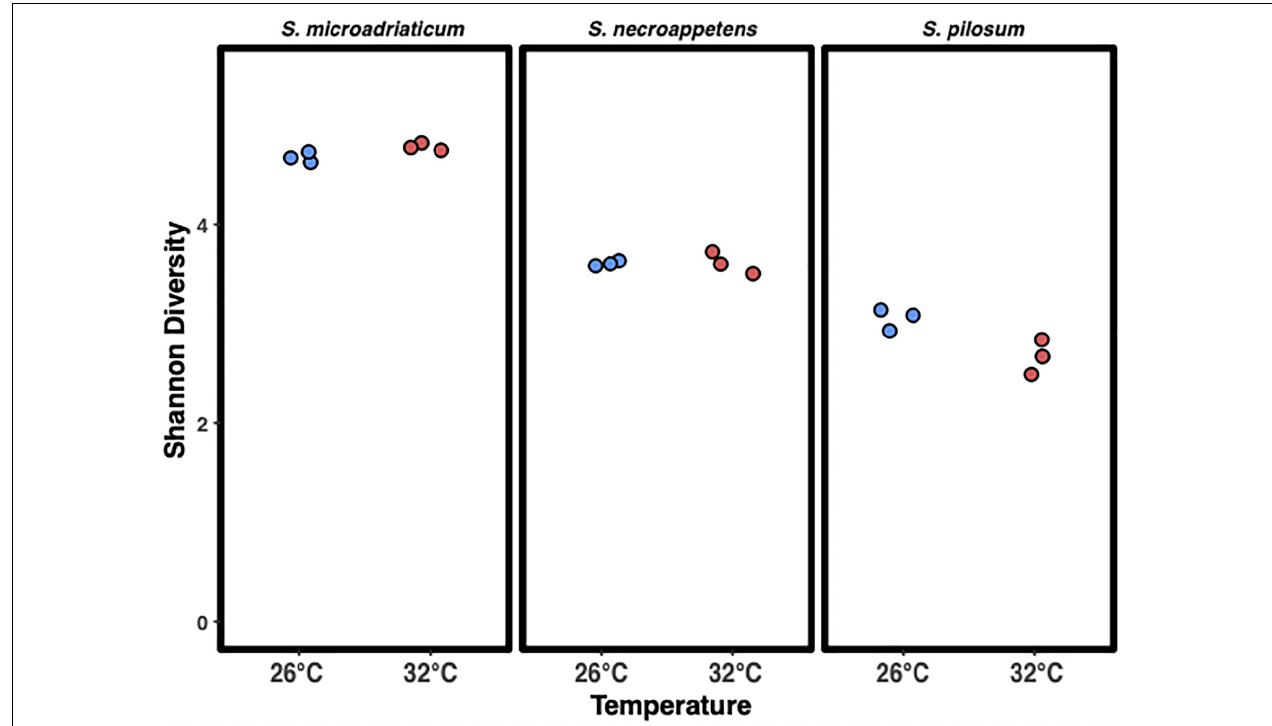
FIGURE 5 | Shannon diversity index of microbial communities associated with Symbiodinium in culture. Blue 26 ◦ C and red 32 ◦ C. There was a significant effect of species and temperature on the Shannon diversity index at the p < 0.0001 level for the three conditions with Symbiodinium pilosum being the only species different by temperature [ F ( 5 , 12 ) = 154.07, p <